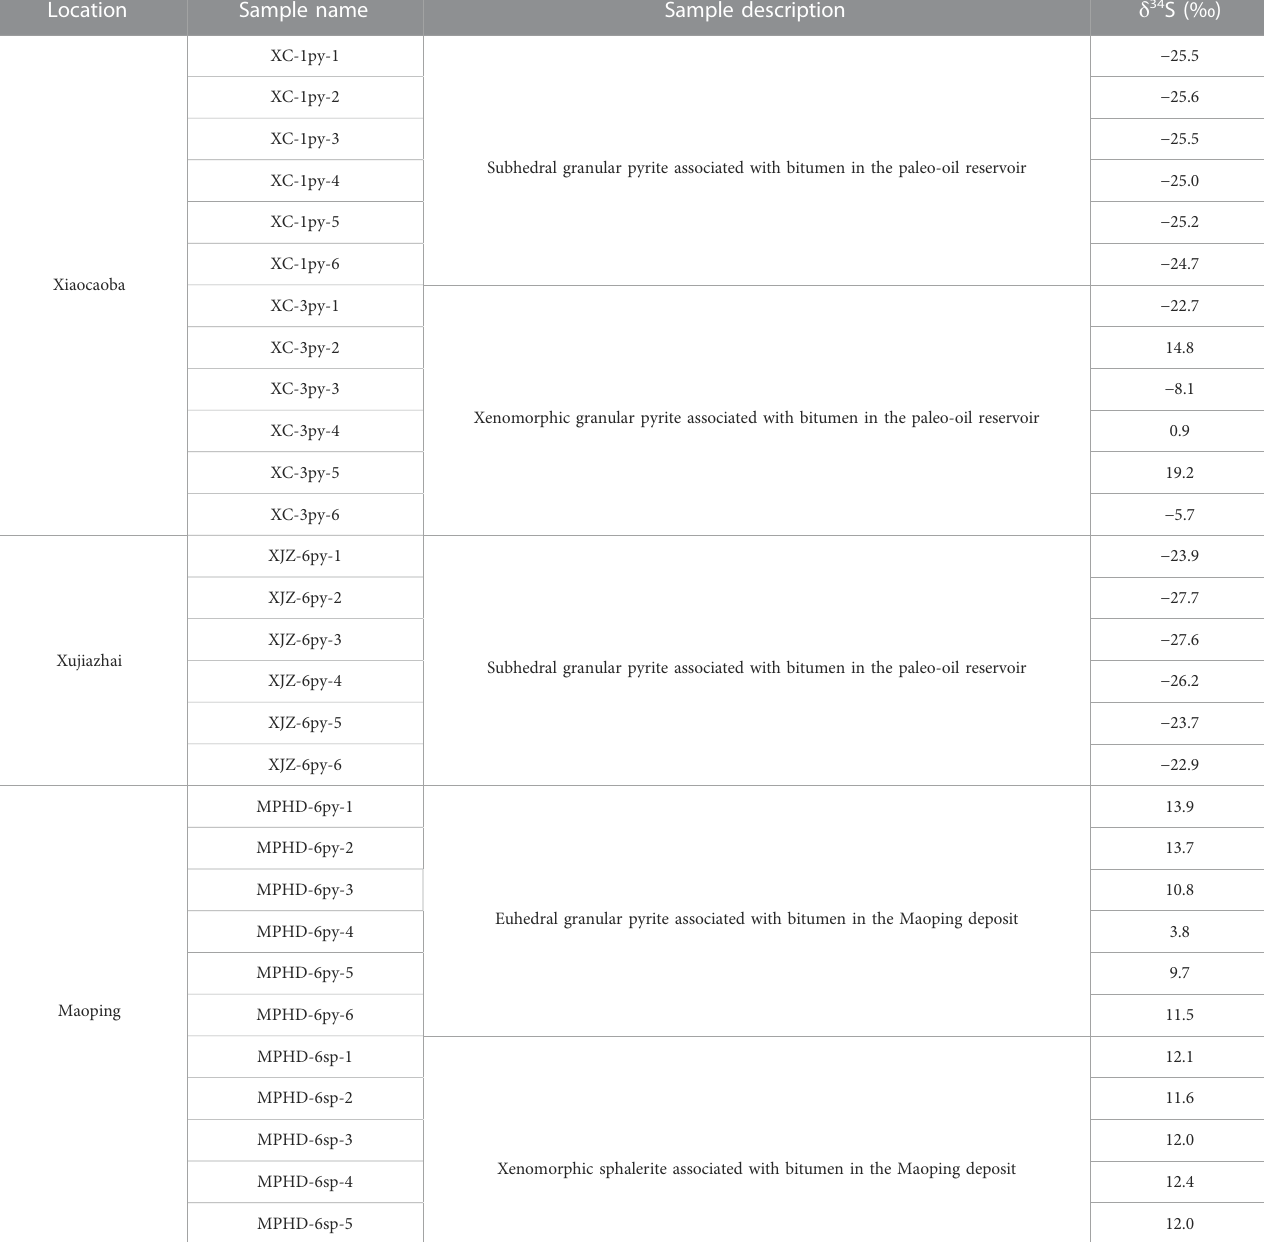
TABLE 3 Sulfur isotope of sul fi des associated with bitumen in paleo-oil reservoirs and the Maoping deposit.